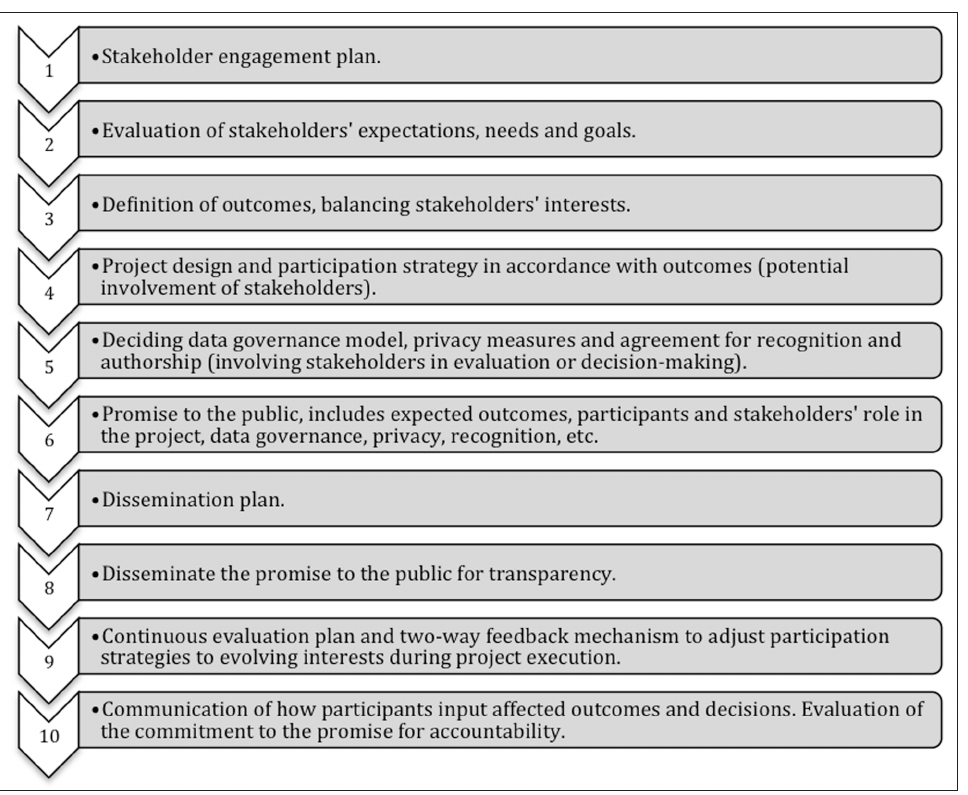
Figure 1: Summary of recommended steps for designing a citizen science project with ethics at its core. Stakeholders are researchers, participants, and organizations involved in the project and directly affected by the project. Table 1: Privacy and data protection problems and solutions identified by Galdon